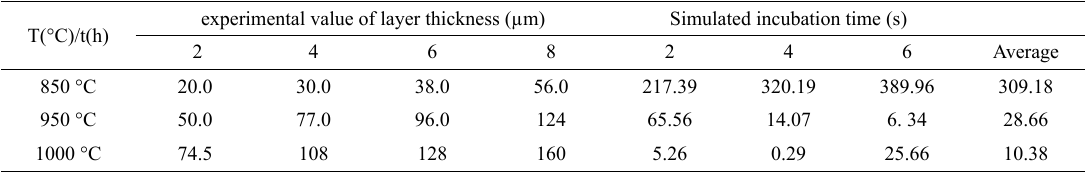
Table 3. The values of the simulated incubation time of the Fe2B boronized layer (τ). experimental value of layer thickness (µm) Simulated incubation time T(°C)/t(h)